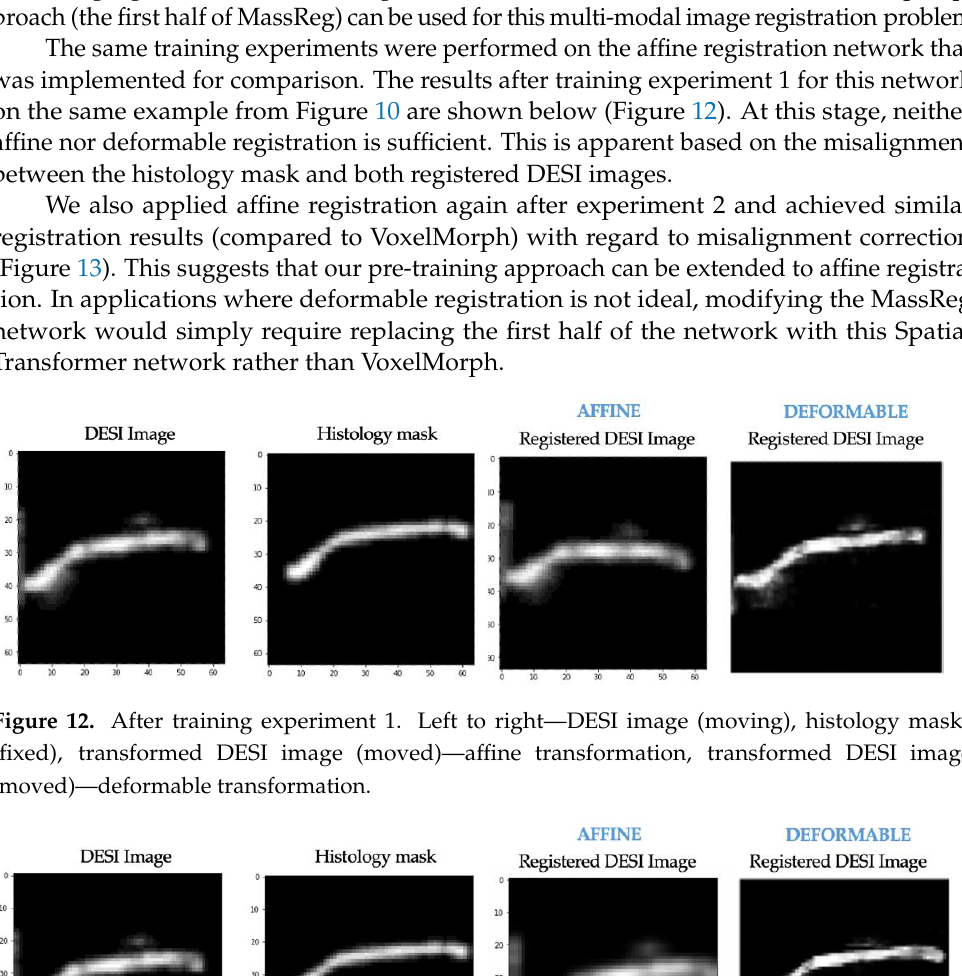
Figure 13. After training experiment 2. Left to right — DESI image (moving), histology masks (fixed), transformed DESI image (moved) — affine transformation, transformed DESI image (moved) — deformable transformation.